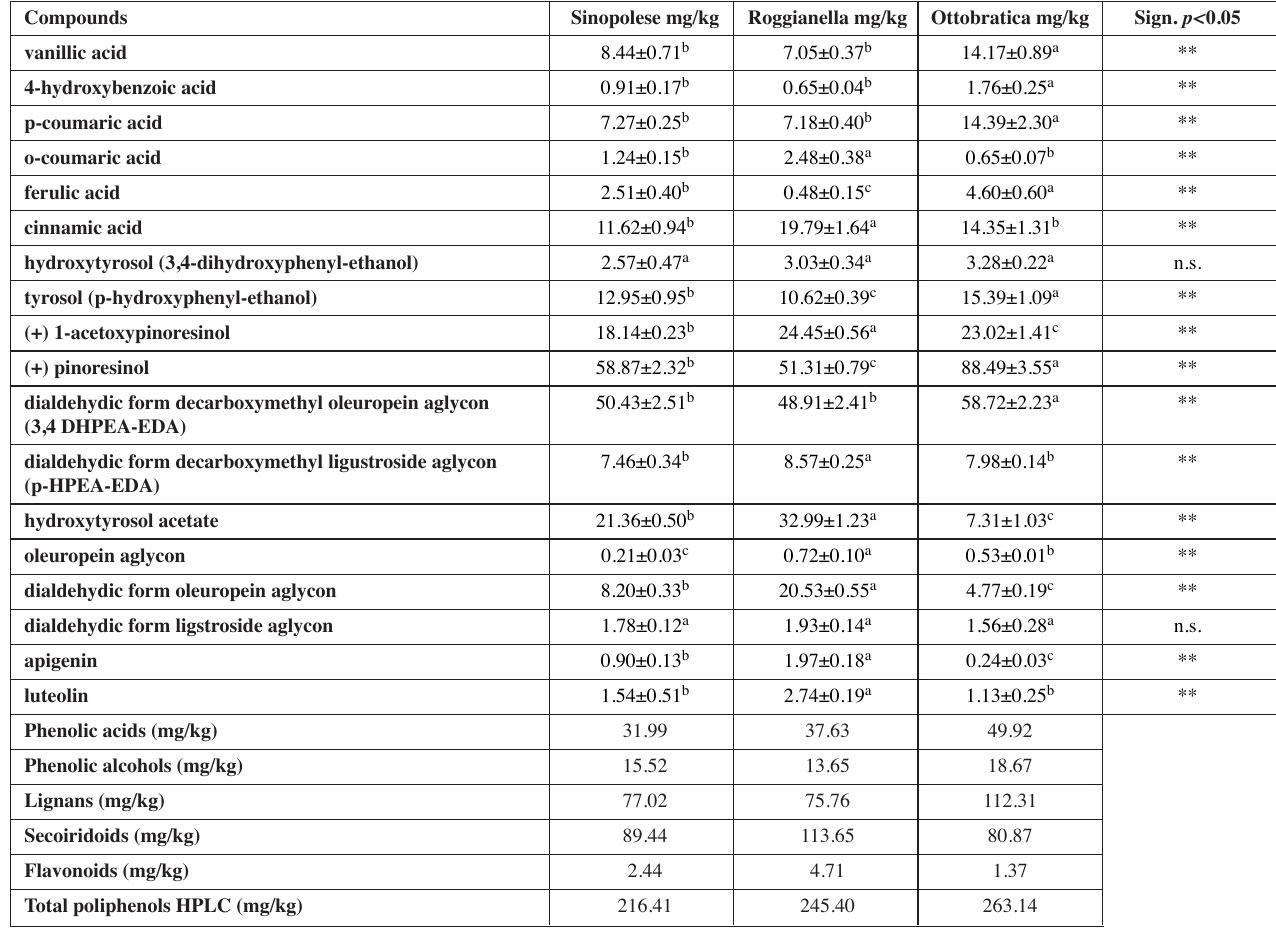
Tab. 2: Phenolic compounds in extra virgin olive oil obtained from the cultivars Sinopolese, Roggianella and Ottobratica Compounds